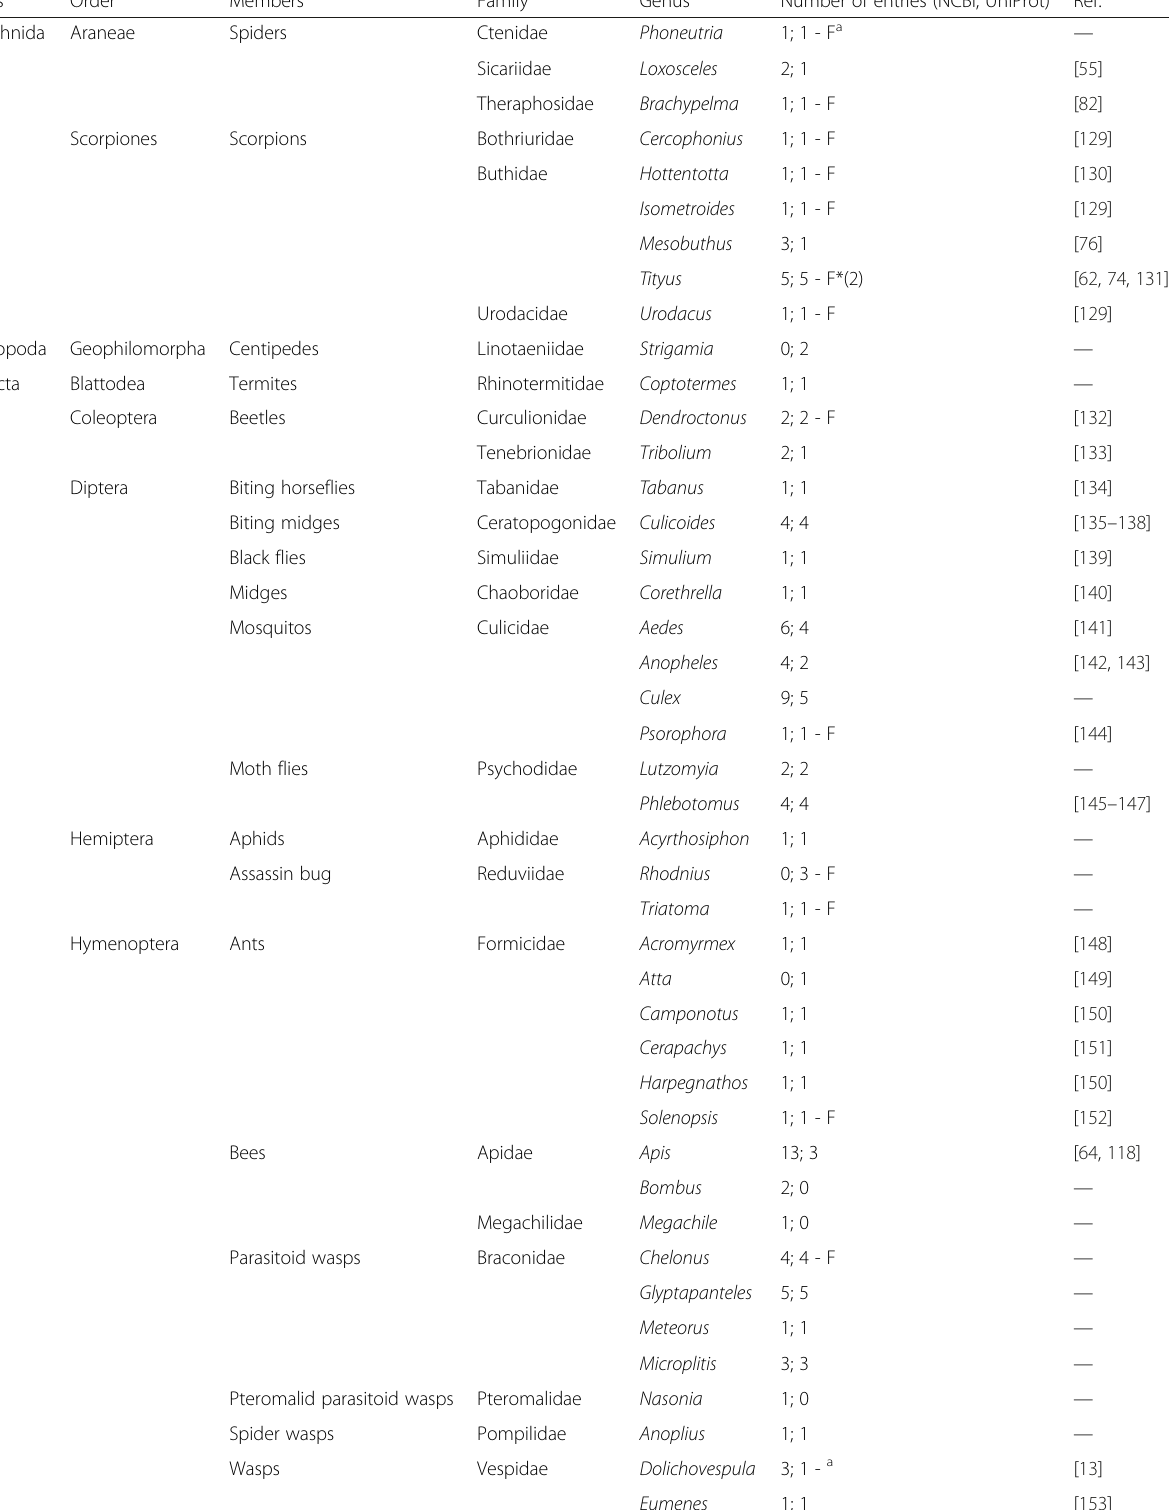
Table 1 Hyaluronidases from the phylum Arthropoda